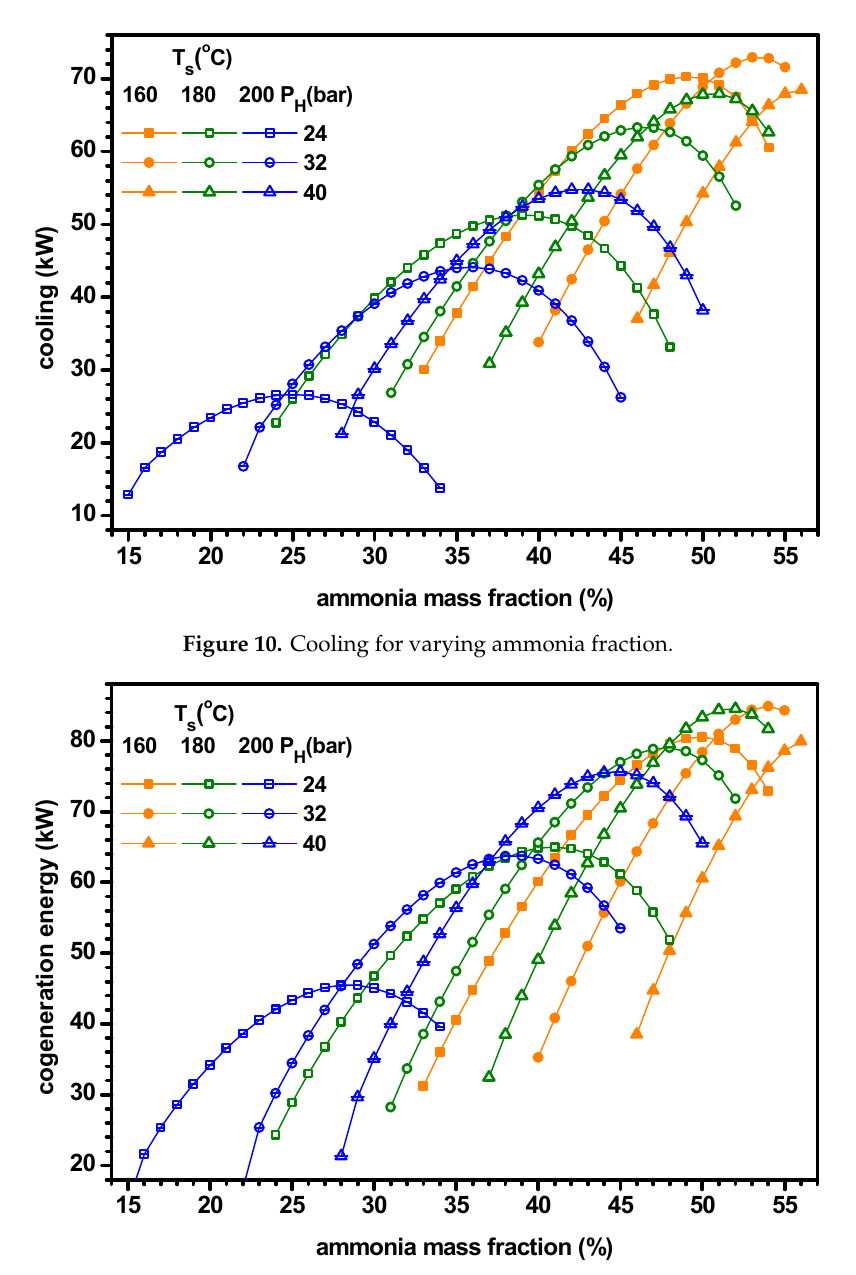
Figure 11. Cogeneration energy for varying ammonia fraction.